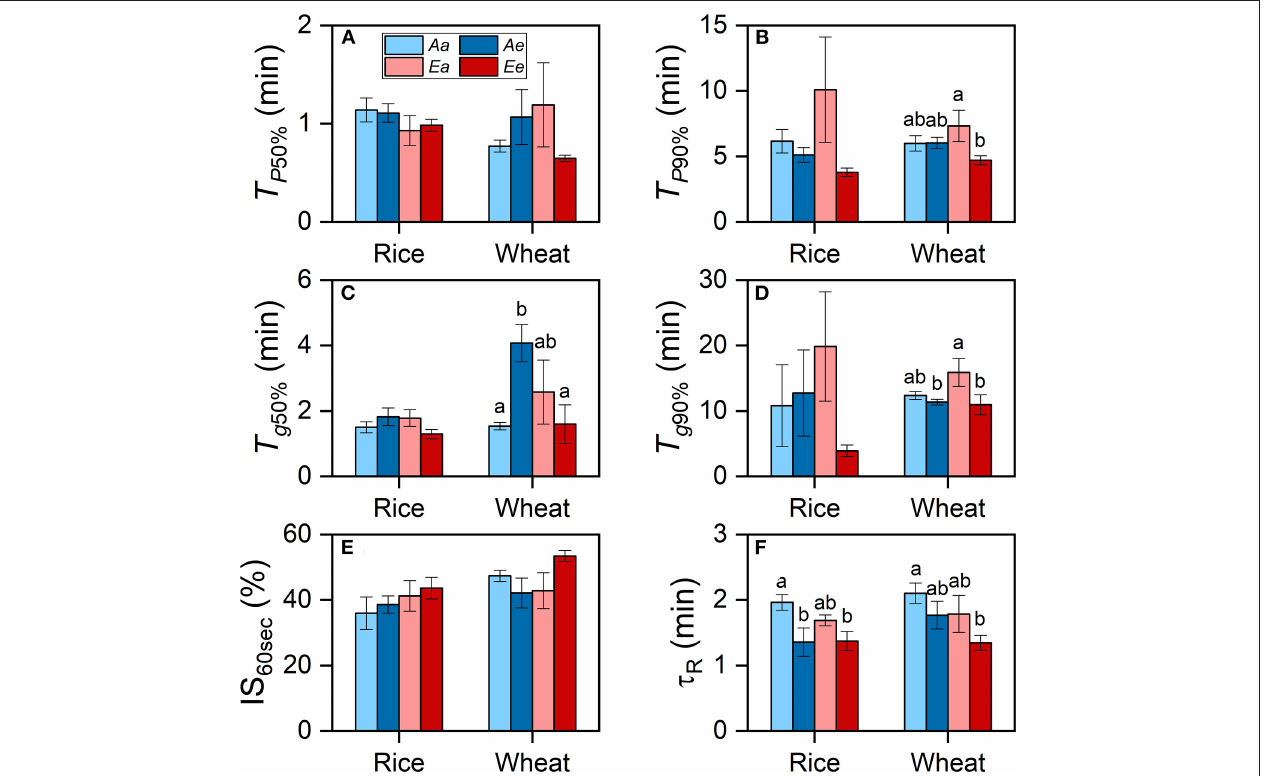
FIGURE 3 | The rates of photosynthetic induction and stomatal opening in rice and wheat leaves. (A) Time required for the photosynthetic rate to reach 50% of P N,1,500 ( T P 50 % ). (B) Time required for the photosynthetic rate to reach 90% of P N,1,500 ( T P 90 % ). (C) Time required for stomatal conductance to reach 50% of g s,1,500 ( T g50 % ). (D) Time required for stomatal conductance to reach 90% of g s,1,500 ( T g90 % ). (E) The IS reached 30s following an increase in light intensity (IS 60s ). (F) The apparent time constant of Rubisco activation ( τ R ). Bars and vertical lines indicate the means and standard errors of three to four biological replicates, i.e., individual plants for each species, respectively. Different letters above error bars indicate significant differences between two treatments within each species. The absence of letters denotes the absence of significant